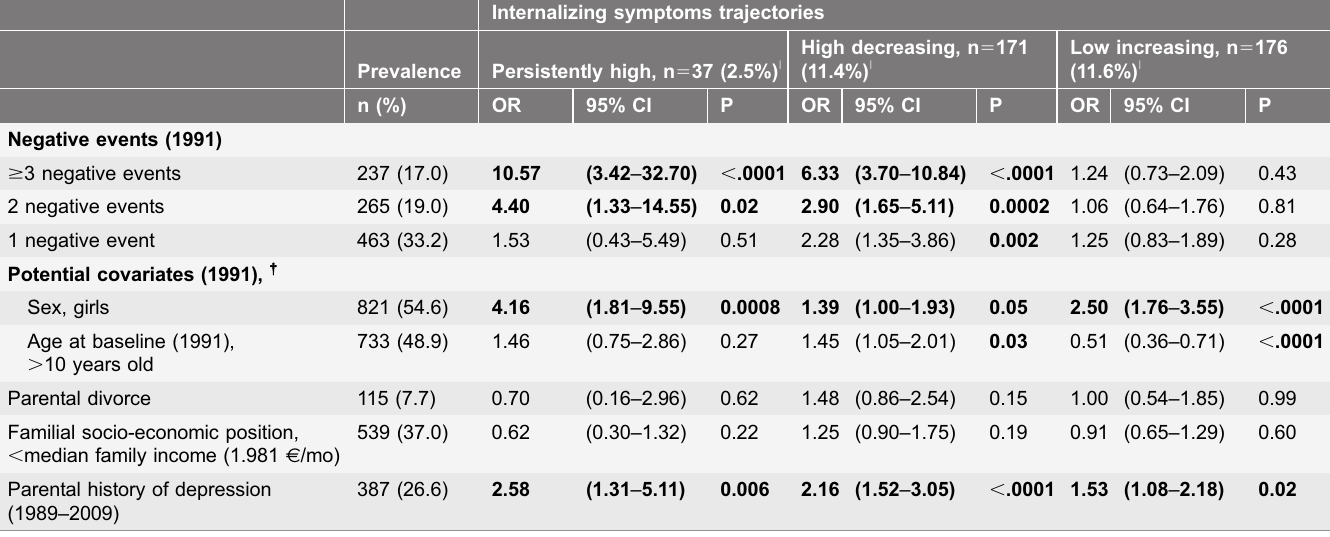
Table 1. Negative childhood events and potential covariates associated with internalizing symptoms trajectories (French TEMPO study, 1991–2009, n 5 1503, age and sex-adjusted ORs, 95% CI). Internalizing symptoms